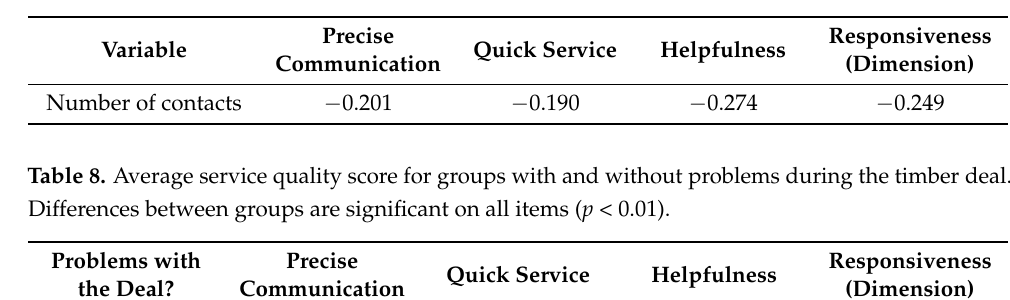
Table 7. Pearson correlation coefficients for the reliability dimension and its three features. All correlations are significant at the 0.01 level (2-tailed).